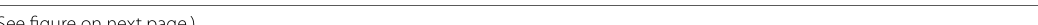
figure on next Fig. 3 Native telomeric FISH for single-stranded C-rich telomeric DNA visualisation as a potent tool for ALT detection in xenograft-derived tumor tissues. a Representative images of PML (IF, green) and telomeres (denaturing FISH, red) staining on frozen xenografts, obtained with LB857/ ALT + or HT1080/TEL + cell lines, and healthy human lung sections. Arrowheads show colocalization events. Scale bars: 5 μm. Quantification of PML-Telomeres colocalization events per nucleus is shown on the right, with each dot representing one nucleus. The red line marks the mean value and SD bar is shown. The graph on the extreme right represents the frequency of nuclei presenting 0 to 2 (grey), 3 to 5 (pink) or more than 5 (blue) colocalization events per nucleus. Single experiment in which at least 100 nuclei were quantified. b Representative images for denaturing telomeric FISH in sections from either FFPE or frozen LB857 Xeno /ALT + and HT1080 Xeno /TEL + xenografts, and frozen healthy human tissue. Scale bars: 5 μm. c Representative images for ultra-bright telomeric signals identified in FFPE and frozen LB857 Xeno /ALT + sections. Scale bars: 5 μm. d Representative images for native FISH experiment in the tissues described in b . The quantification is shown below, with each dot representing the number of ss-TeloC signals in one nucleus. Mean SD. The frequency of nuclei showing 0 (grey), 1 (pink) or more than 1 (green) ss-TeloC signals per nucleus is + shown in the graph on the right. Single experiment in which at least 200 nuclei were quantified. Scale bars: 5